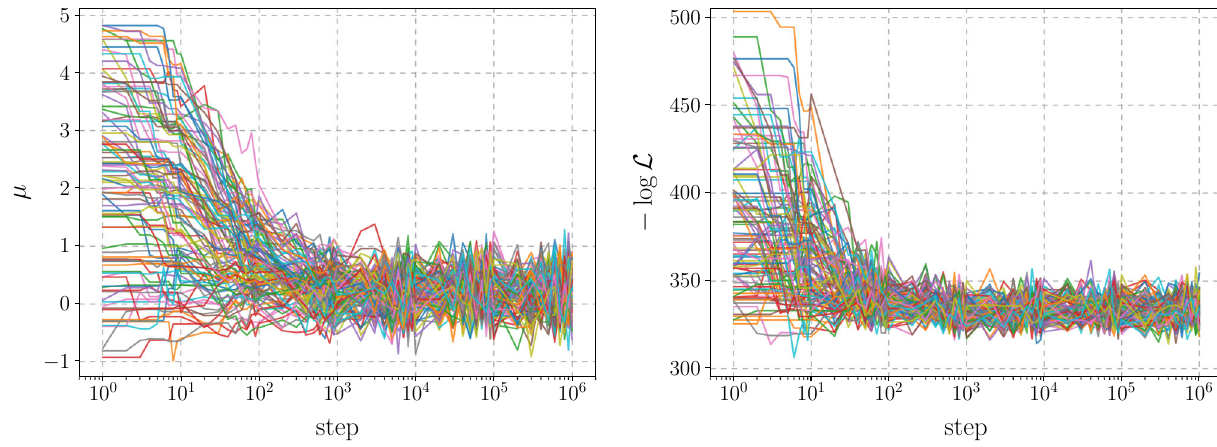
Fig. 1 Evolution of the chains in an emcee3 sampling of the LF in Eq. (11) with 10 3 walkers and 10 6 steps using the StretchMove algo- rithmwith a = 1 . 3.Theplotsshowtheexploredvaluesoftheparameter μ (left) and of minus log-likelihood − log L (right) versus the number of steps for a random subset of 10 2 of the 10 3 chains. The parameter μ